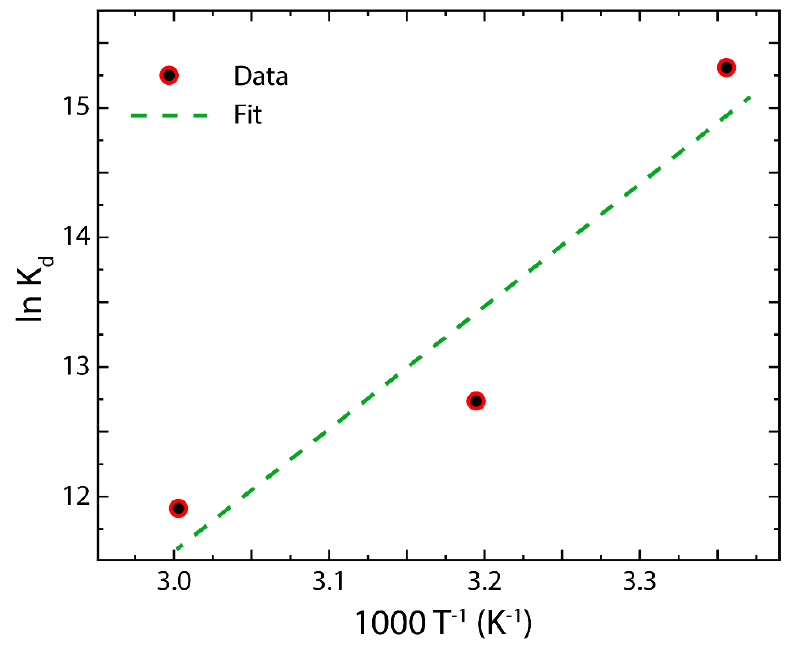
Figure 10. Analysis of the adsorption of Hg(II) on rGO by the Van ‘ t Hoff approach. Table 6. Parameters of the adsorption thermodynamics at 298, 313, and 333